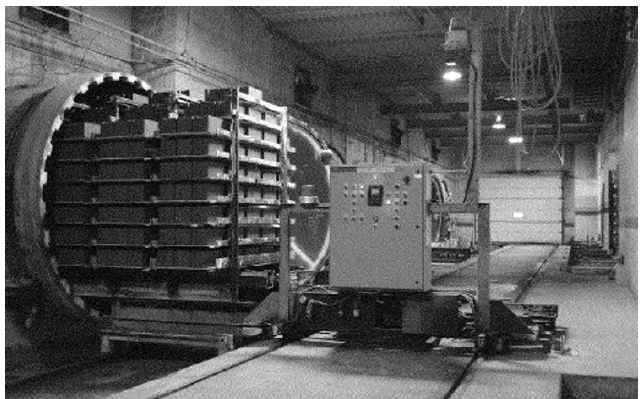
Figure 7. Carbonation chamber developed by Carboclave. Source: